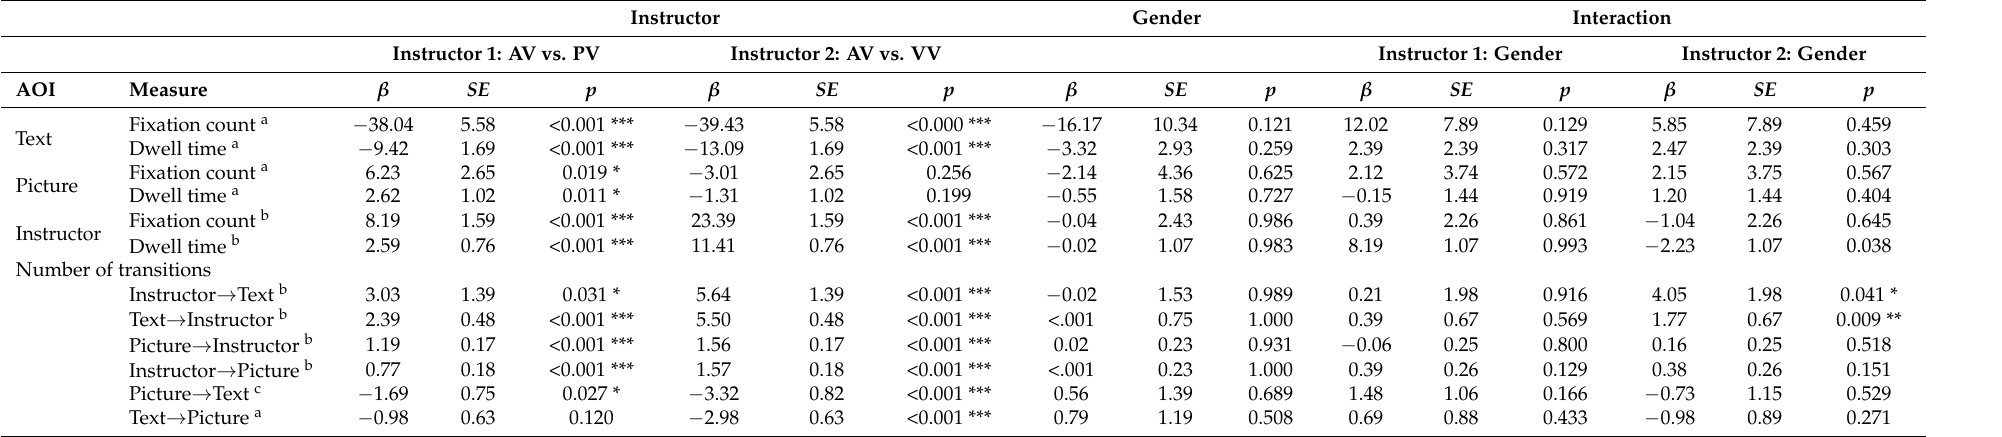
Table 4. LMM statistics for eye movement